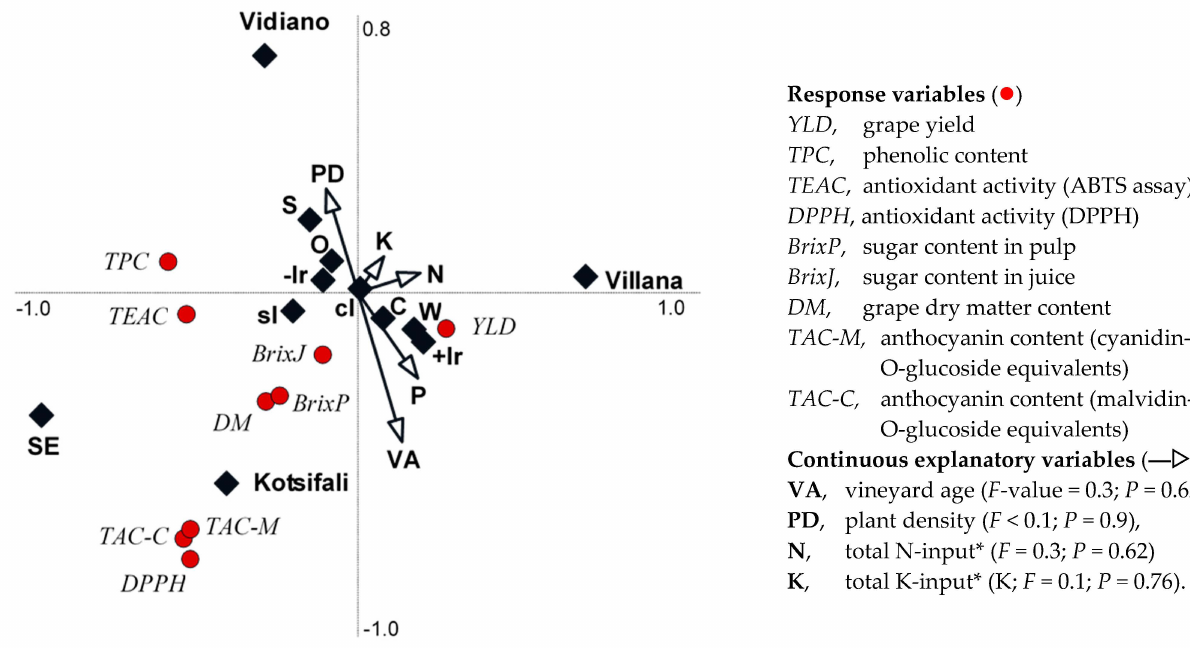
Figure 2. Biplot derived from the redundancy analysis showing the relationship between variety, production system, agronomic, and orchard site and soil explanatory variables/drivers and grape yield and quality parameters. Eigenvalues were 32.5% and 8.6% for Axis 1 and 2, respectively. Fixed explanatory variables ( ) were (a) variety: Vil , Villana ( F = 17.1, P = 0.002); Vid , Vidiano ( F = 5.7, P = 0.018); Kot , Kotsifali ( F = 5.7; P = 0.018), (b) irrigation: +Ir , with drip irrigation ( F = 1.3, P = 0.27); − Ir , without drip irrigation ( F = 1.3, P = 0.27), (c) orchard orientation, facing: W , west ( F = 0.9, P = 0.36); S , south ( F = 0.6, P = 0.44); SE , southeast ( F = 0.6, P = 0.44), (d) production system (organic ( O ), F = 0.6, P = 0.44; conventional ( C) F = 0.6; P = 0.44), and (e) soil texture: cl, clay loam ( F = 0.4, P = 0.59); sl , sandy loam ( F = 0.4, P = 0.59). * From mineral and/or organic fertilizer.